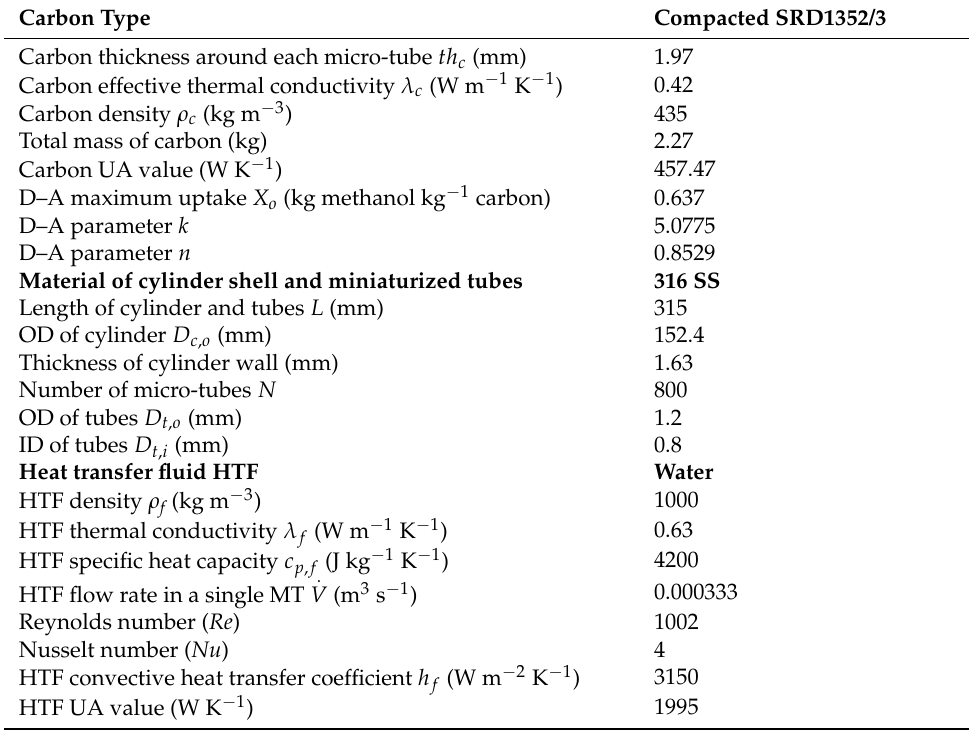
Table 1. MT-HEX reactor model